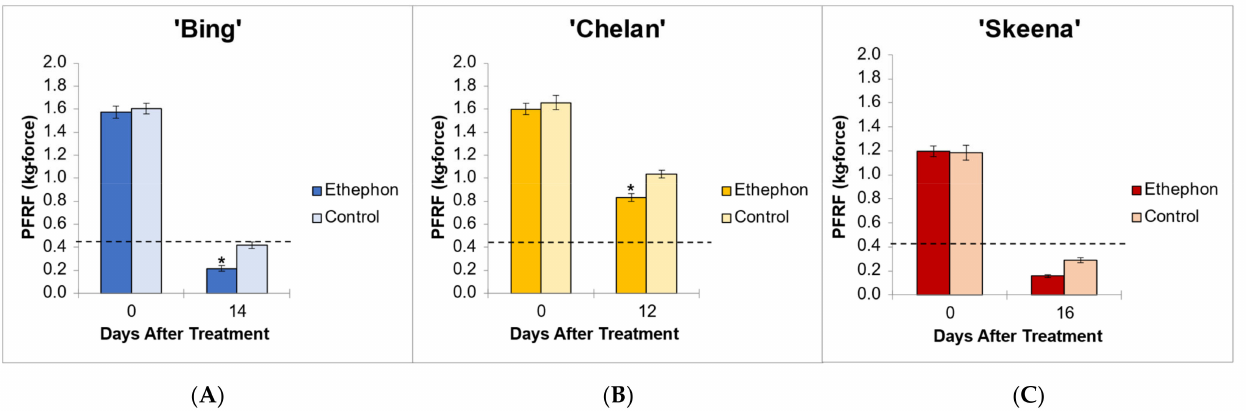
Figure 1. Endpoint mean control and ethephon-treatment PFRF values for ( A ) ‘Bing’ ( B ), ‘Chelan’, and ( C ) ‘Skeena’ PFAZ tissues. The dotted line represents the threshold PFRF for mechanical harvest. Asterisks indicate significant difference between ethephon-treated and control fruit at harvest ( p <